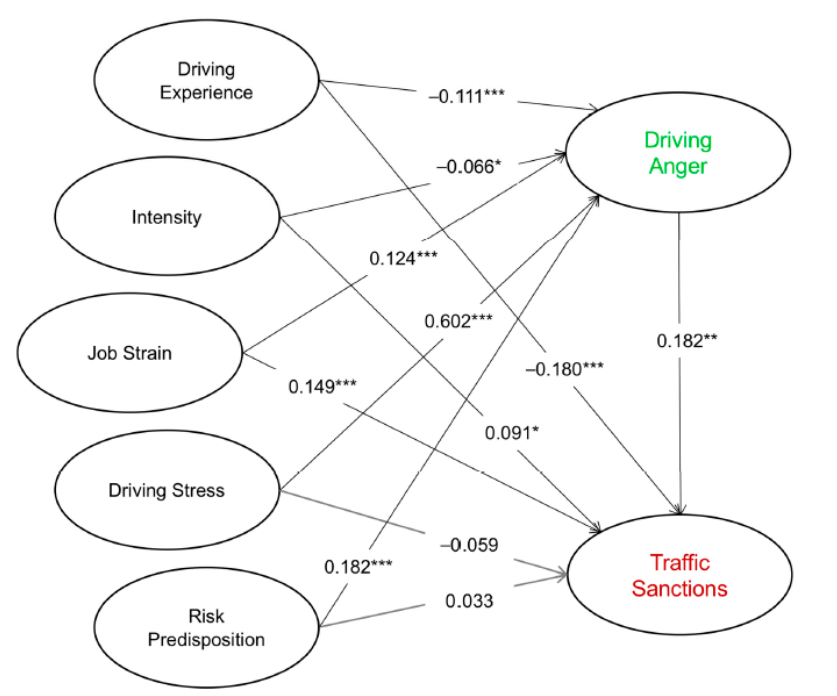
Fig. 1 The stress process of college students induces depressive symptoms, which leads to light business thoughts.